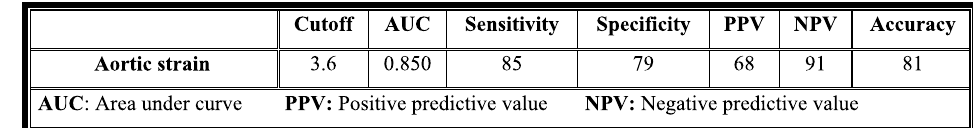
Fig. 4 The receiving operator characteristics curve for aortic